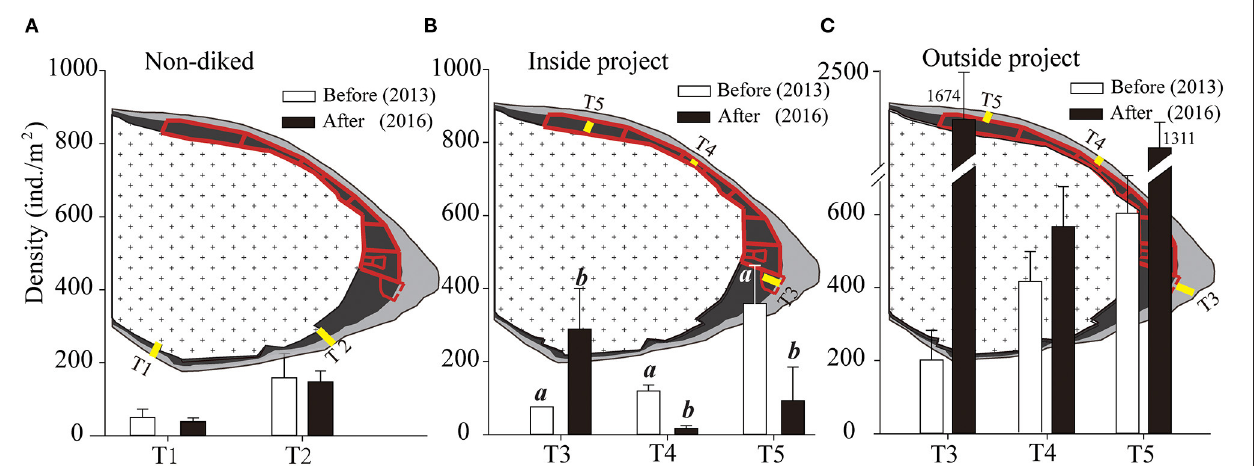
FIGURE 2 | Benthic macroinvertebrate density in different transects before and after diking in the Chongming Dongtan salt marsh, Yangtze Estuary, China. Mean values with one SE (error bars) are shown, and different characters ( a , b ) indicate that values were significantly different before and after diking ( t -test, P < 0.05). (A) Non-diked area, (B) inside the dike project, and (C) outside the dike project area.